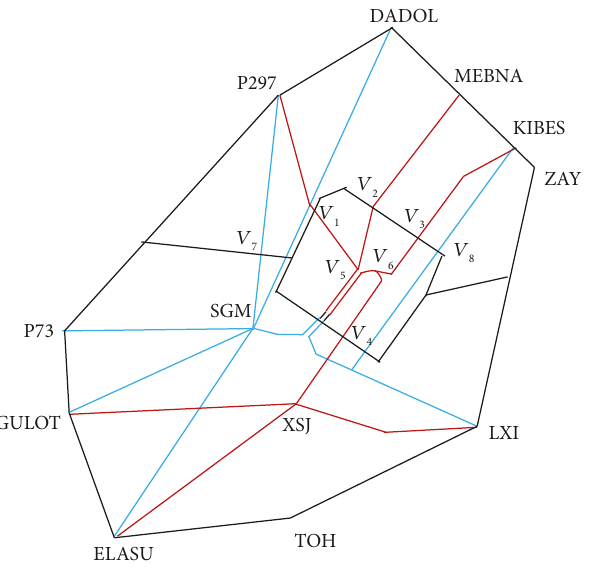
Figure 3: Sectors of terminal airspace.